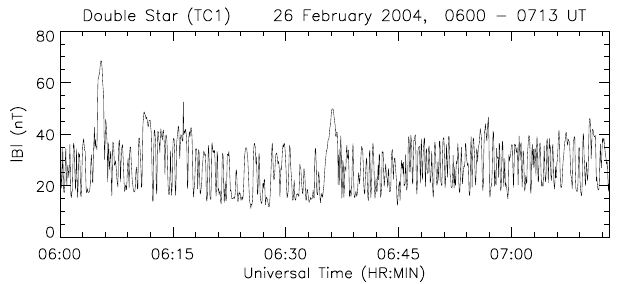
Fig. 3. The magnitude | B | of magnetic file measured by TC-1 in the magnetosheath during the interval from 06:00UT to